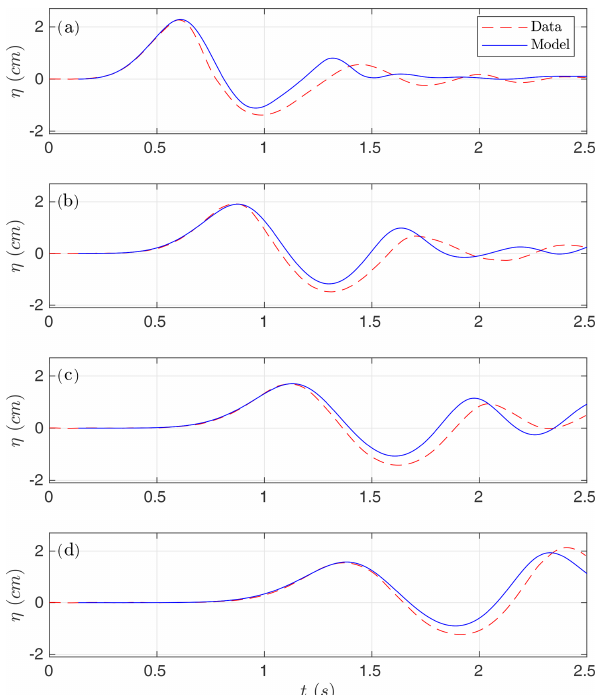
Figure 7. Numerical time series for the simulated water surface (in blue) compared with lab-measured data (red). Case 2 at gauges (a) G1, (b) G2, (c) G3, and (d) G4.